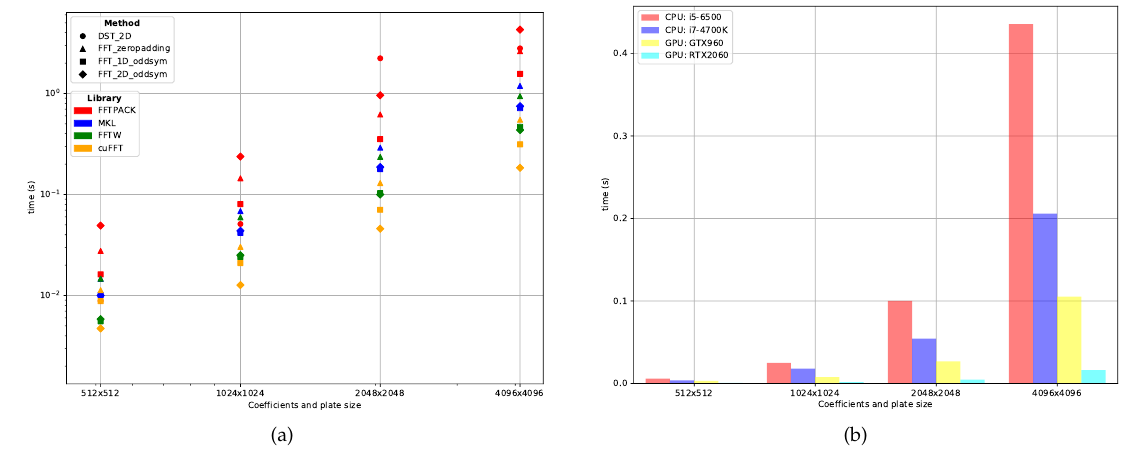
Figure 12. CPU and GPU computation time comparison using different plate resolutions. ( a ) Computing time for each scheme, grouped by library as per Table 3; ( b ) Computing time for the 2D odd symmetric FFT